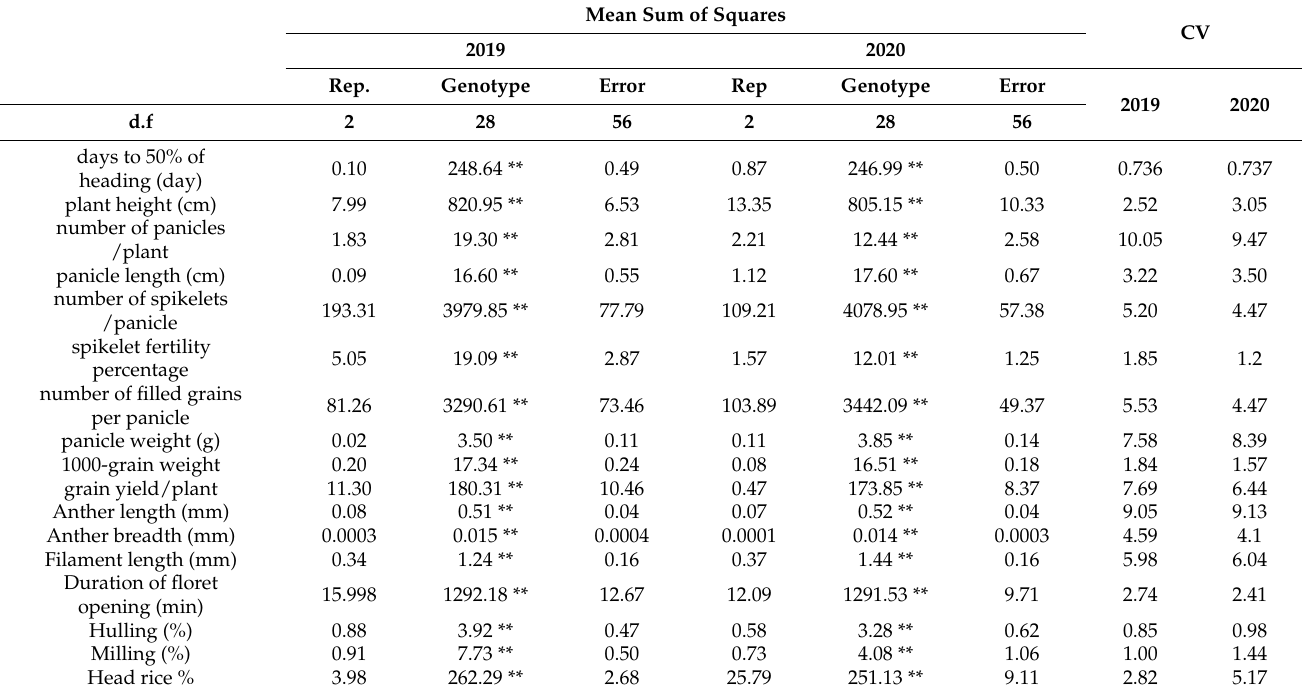
Table 2. Analysis of variance for the grain yield and the contributing traits of the studied genotypes during the 2019 and 2020 growing